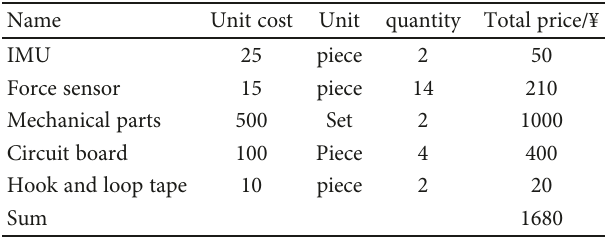
Figure 3: The mechanical structure of the wearable sensing system for AIDER. (a) The structure of the wearable sensing system. (b) The prototype of the wearable sensing system. (c) The coordinate system for the left foot. Table 2: The cost of wearable sensing